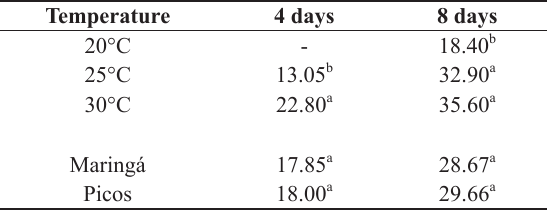
Effect of temperatures on the mean number of germinated seeds (40 seeds for repetition; 10 repetitions) from Maringá (Southern region of Brazil) and Picos (Northeastern region of Brazil).